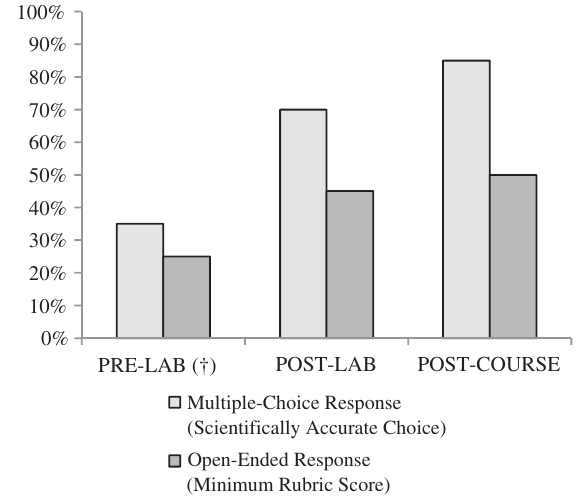
FIG. 3. Percentage of students meeting minimum criteria when asked about the length and direction of their shadow over a two week period ( n ¼ 20 ).